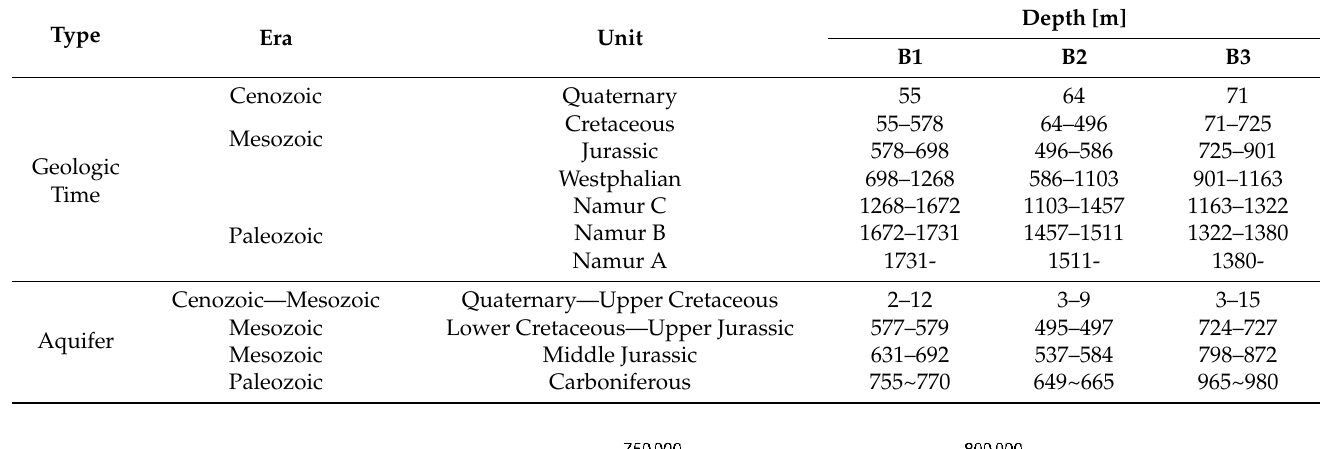
Table 1. Stratigraphy and depth of geological strata and aquifers in the area of interest in chosen boreholes. Note that borehole B1 is located in the drainage center, whereas boreholes B2 and B3 are placed in the northeast, small dip angle wing and southwest steep dip angle wing of the synclinorium, respectively (see Figure 2 for the location of boreholes). Source of data: the Polish Geological Institute-National Research.